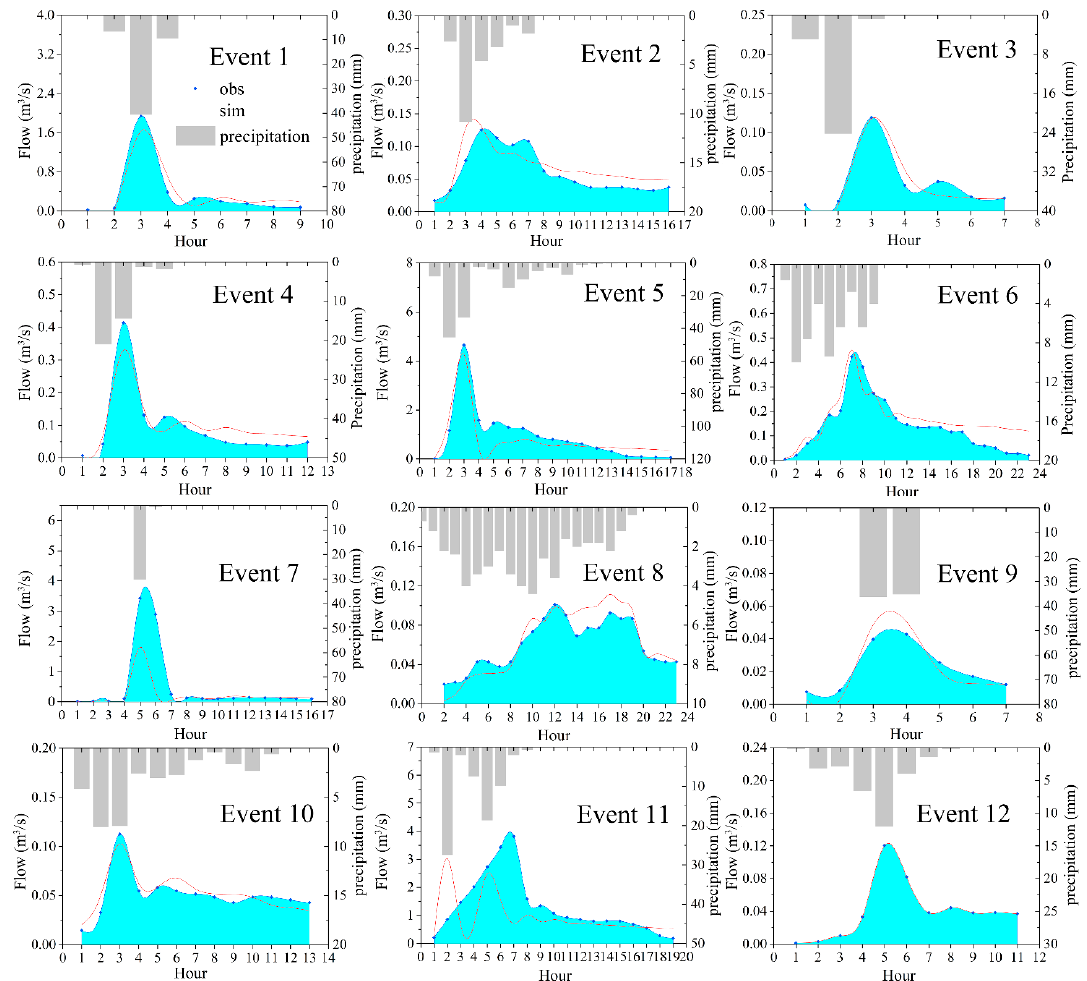
Figure 7. Hyetograph, and simulated and observed hydrographs in the calibration and validation periods for the 12 rainfall–runoff events. Table 4. Summary of calibration statistics for the continuous modeling.